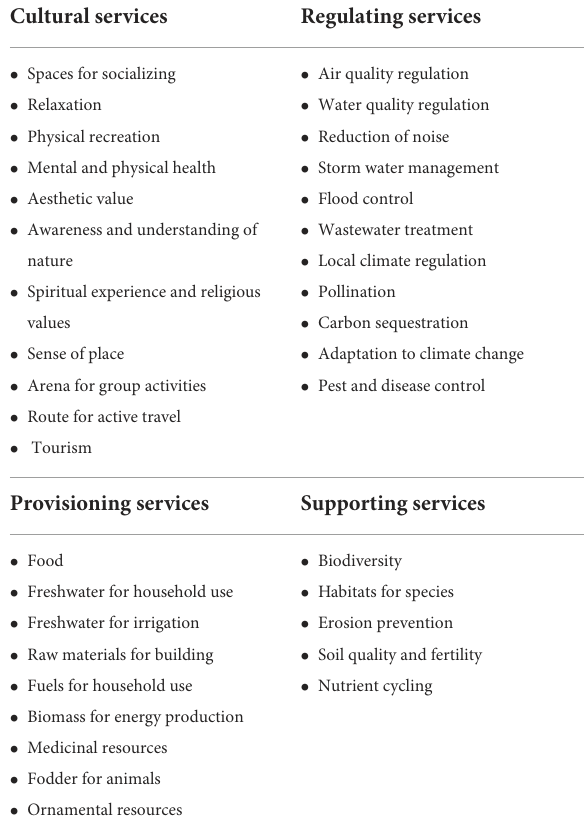
TABLE 2 List of the 36 urban ES explicitly considered in our